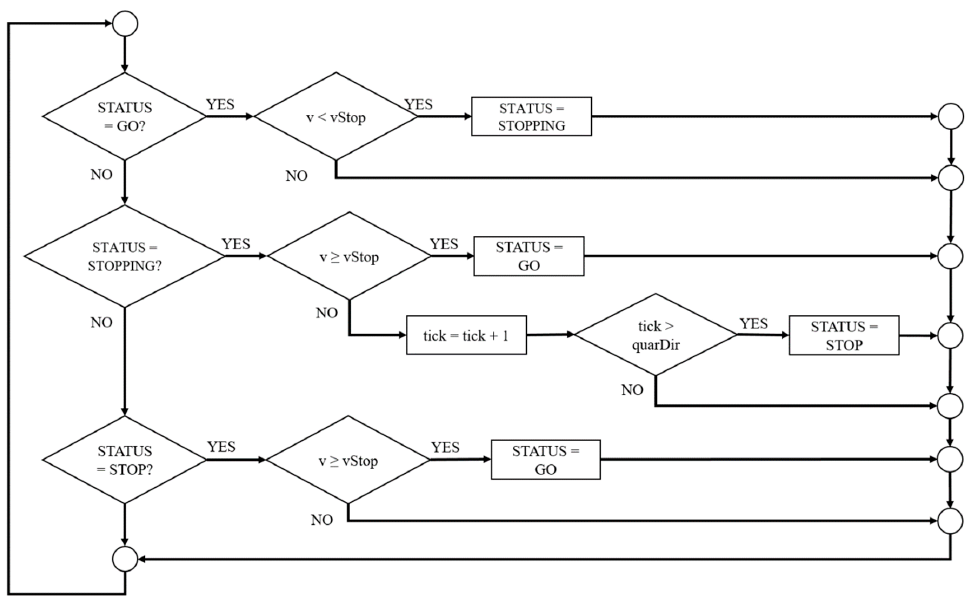
Figure 3. Flowchart showing the state machine used to detect the GO-STOP events